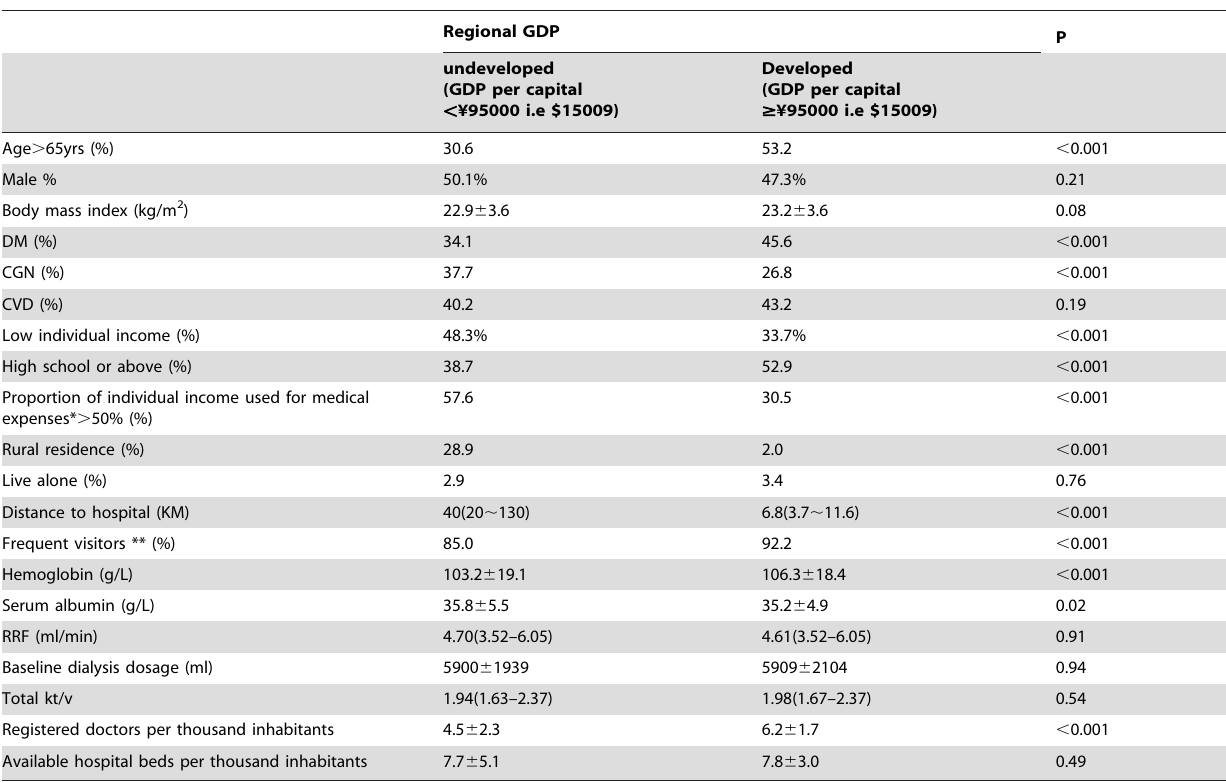
Table 2. Baseline characteristics according to regional